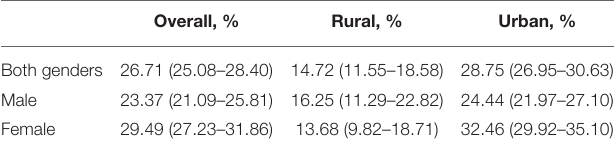
TABLE 1 | Prevalence and 95% CI of diabetic neuropathy by gender and living area. Overall, % Rural, % Urban,